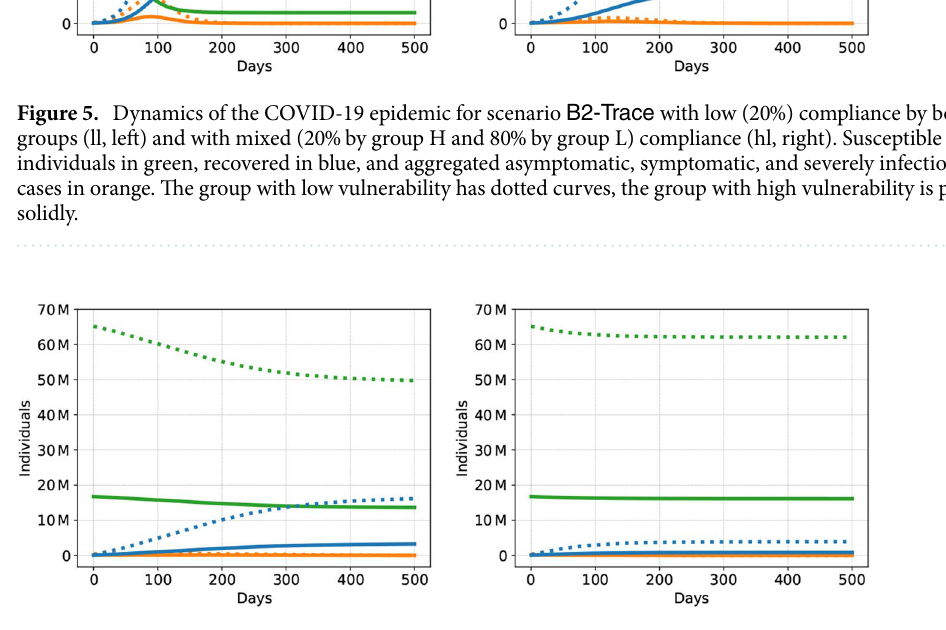
Figure 6. Dynamics of the COVID-19 epidemic for scenario GSD3-Trace with low (20 % ) compliance by both groups (ll, left) and with mixed (20 % by group H and 80 % by group L) compliance (hl, right). Susceptible individuals in green, recovered in blue, and aggregated asymptomatic, symptomatic, and severely infectious cases in orange. The group with low vulnerability has dotted curves, the group with high vulnerability is plotted